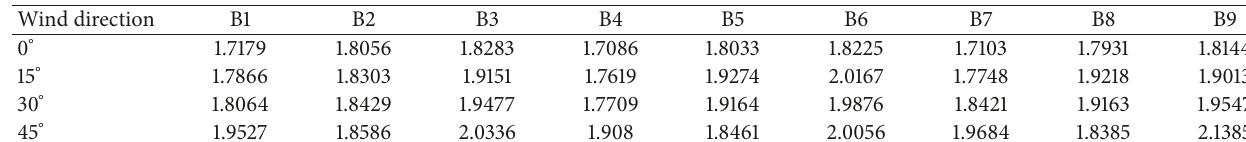
Table 3: Displacement vibration coefficients of points on surface B.